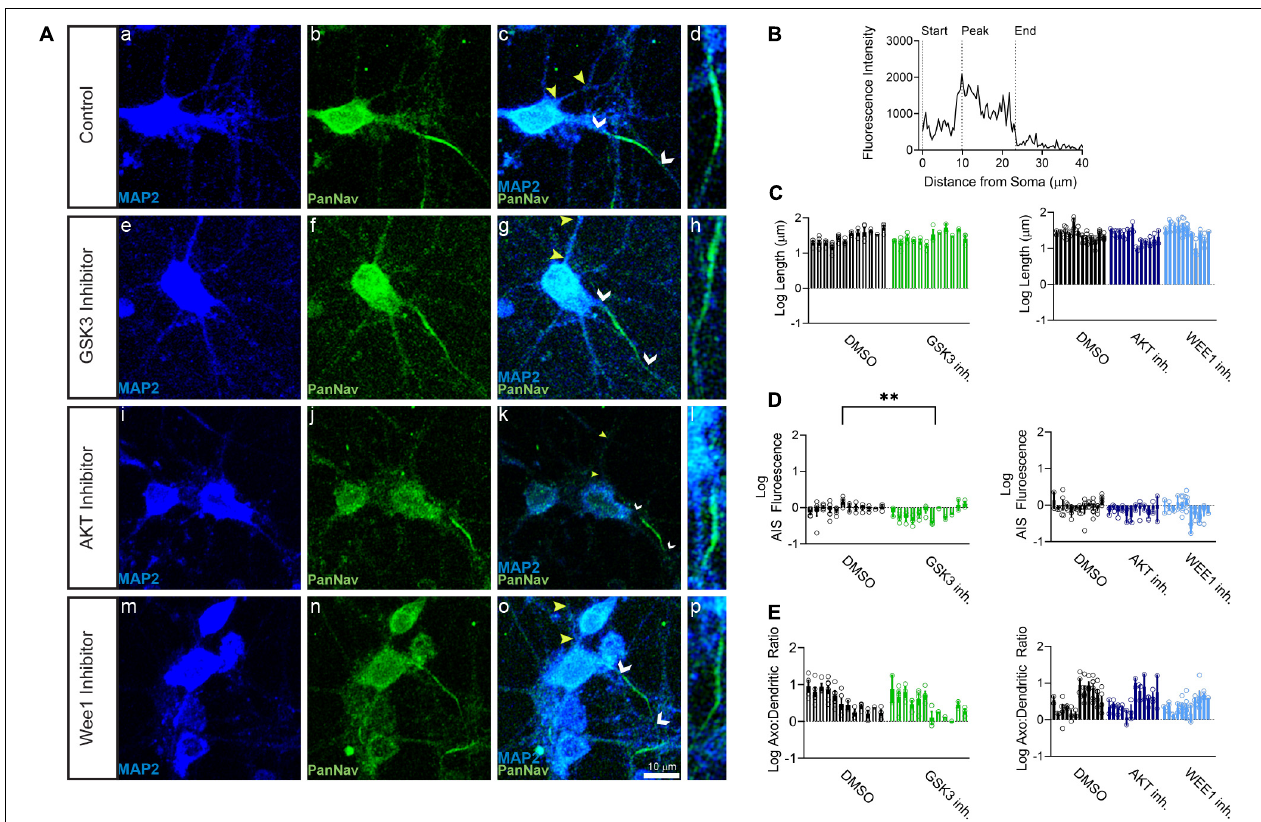
FIGURE 3 | PanNav fluorescent intensity is decreased at the AIS by GSK3 inhibitor treatment. (A) Representative images of expression of (a,e,i,m) MAP2 (blue), (b,f,j,n) PanNav (green), (c,g,k,o) merge of all channels with white arrows indicating the AIS and yellow arrows indicating a dendrite, d,h,i,p) zoom to AIS. (a–d) Neurons treated with 0.5% DMSO (control). (e–h) Neurons treated with 5 µ M GSK3 inhibitor CHIR99021. (i–l) Neurons treated with 25–30 µ M AKT inhibitor triciribine. (m–p) Neurons treated with 5–10 µ M Wee1 kinase inhibitor II. (B) Profile of PanNav fluorescent intensity from the AIS highlighted in panel (d) with the peak of fluorescent intensity, AIS start and AIS end noted as described in the “Materials and Methods”. (C) The length of the PanNav from the AIS is not affected by treatment with the GSK3 inhibitor CHIR99021 ( p = 0.9610), AKT inhibitor triciribine ( p = 0.5544), or Wee1 kinase inhibitor II ( p = 0.5758). (D) Fluorescent intensity of PanNav at the AIS is decreased following treatment with the GSK3 inhibitor CHIR99021 ( p = 0.0061). (E) The axo:dendritic ratio of PanNav is not affected following treatment with CHIR99021 ( p = 0.3904), triciribine ( p = 0.9767), or Wee1 kinase inhibitor II ( p = 0.3809). All data are mean ± SEM ∗∗ p < 0.01 by Nested One-Way ANOVA with Dunnett’s multiple comparisons test or Nested T -Test using a separated scatter graph with